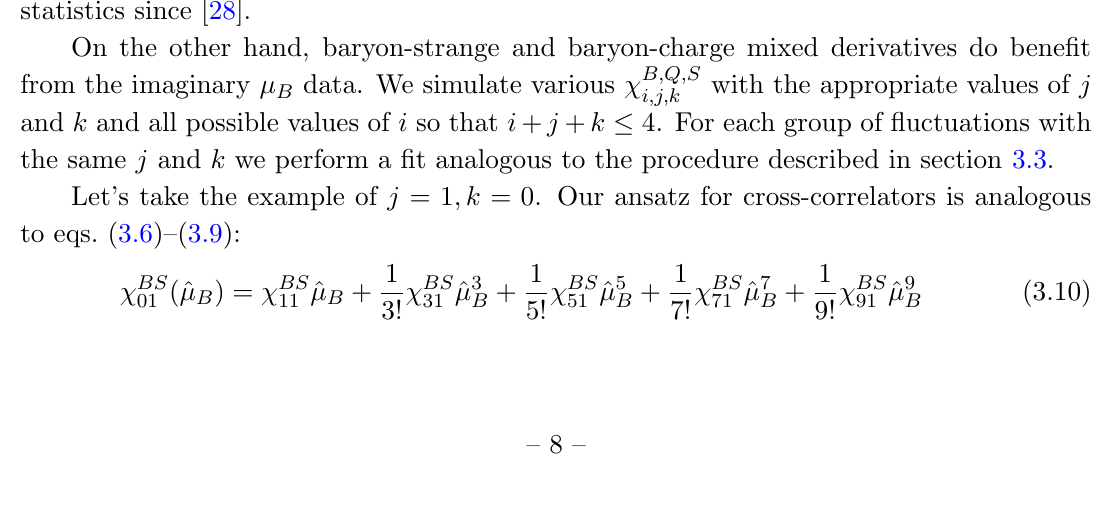
Figure 3 . Results for (cid:31) B from the single-temperature analysis. We plot (cid:31) B guided by a prior, which is linked to the (cid:31) B corresponds to the Hadron Resonance Gas (HRG) model